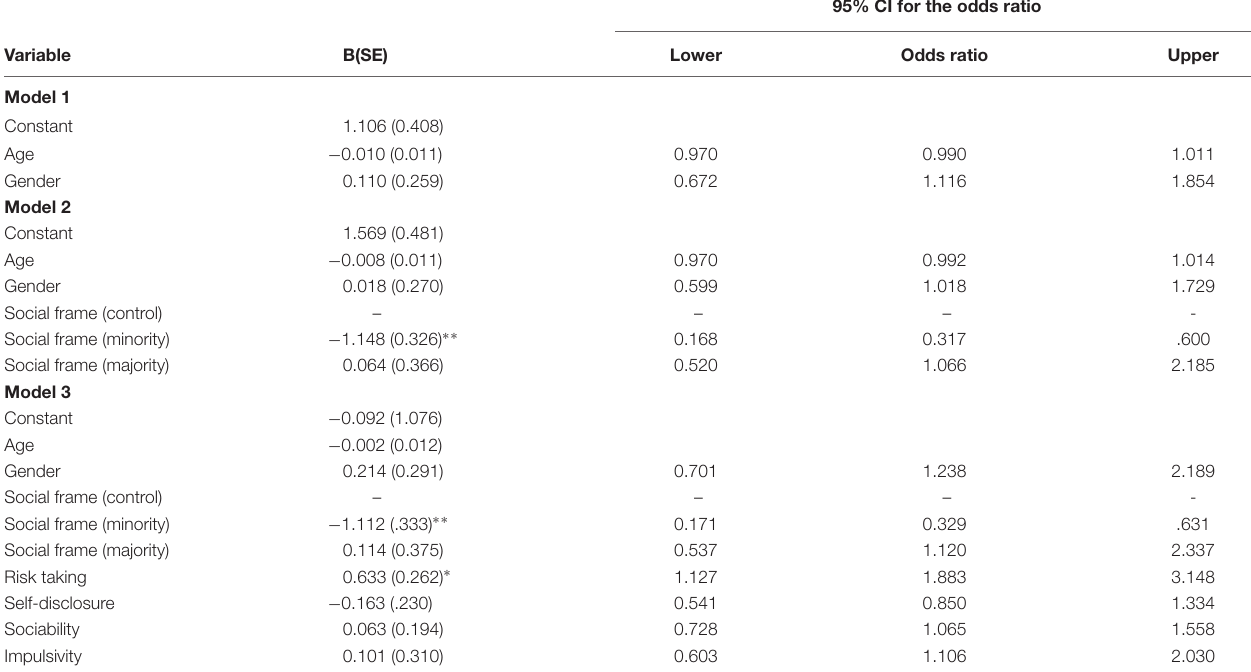
TABLE 4 | Coefficients of the model predicting whether a user would accept the